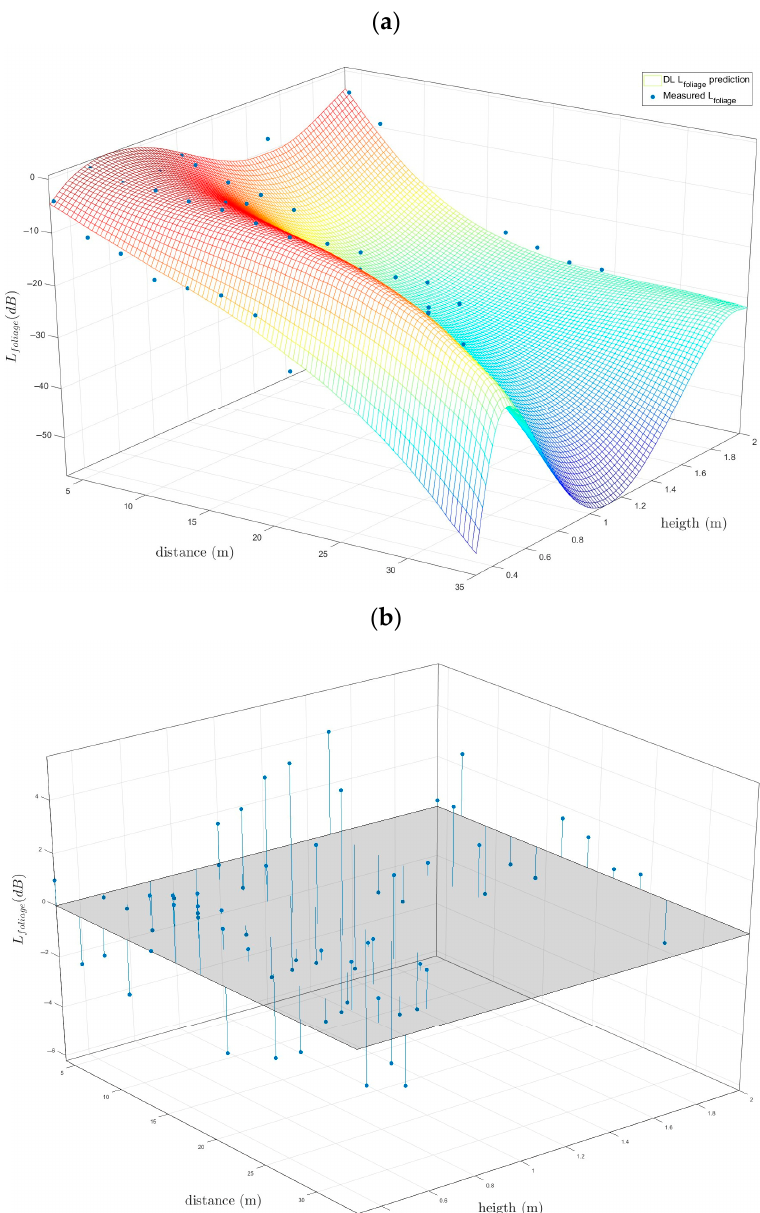
Figure 8. ( a ) The black dots represent the values taken in field tests, together with the L foliage ( d , h ) optimized for the deep learning model. ( b ) Difference between measured and predicted data are the Residual values of L foliage ( d , h ) .